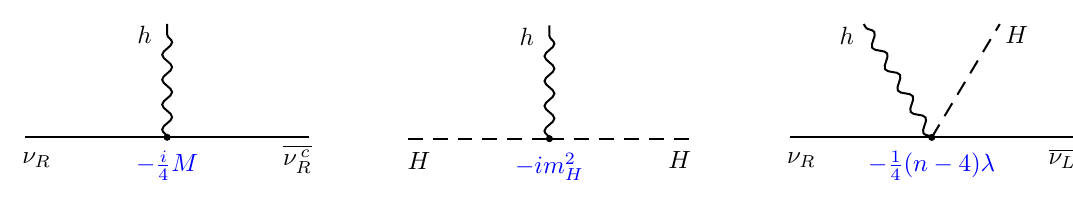
Figure 4 . Elementary gravitational couplings in the fundamental theory in the weak-(cid:12)eld limit. terms at low energy and (cid:12)rst order in the curvature shown in (3.1). This includes both CP conserving and violating operators, re(cid:13)ecting the potential breaking of CP invariance by the Yukawa couplings in the fundamental